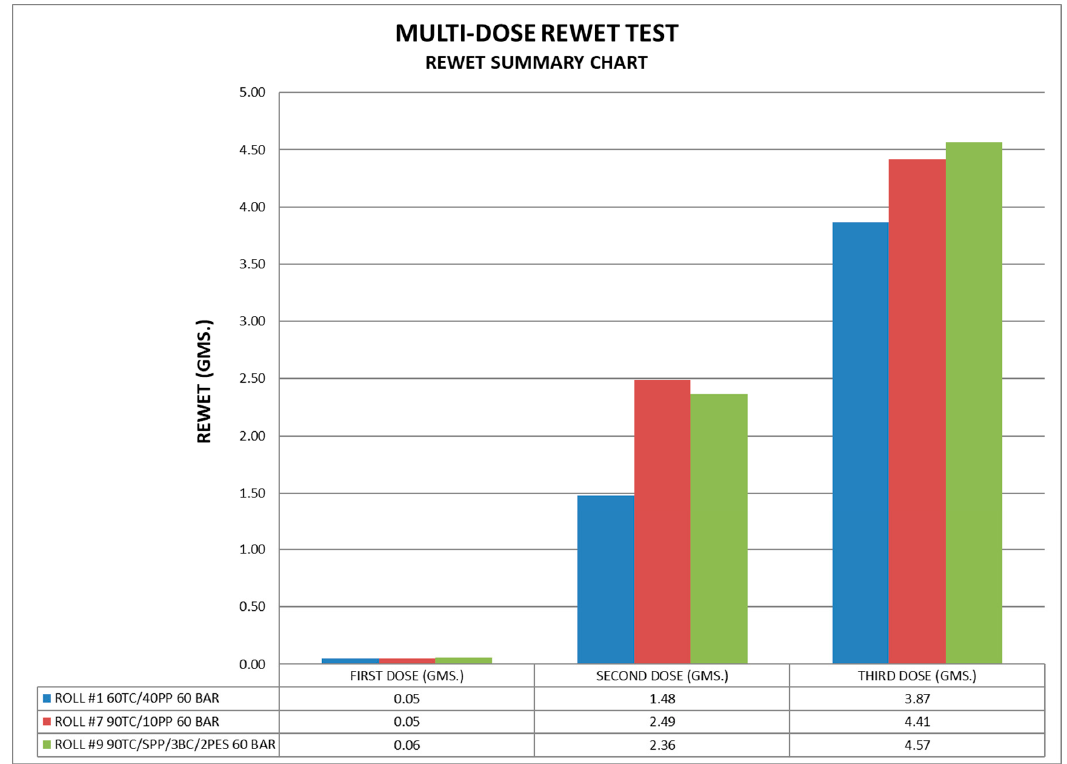
Figure 6. Comparison of multi-dose rewet of three nonwoven fabrics.